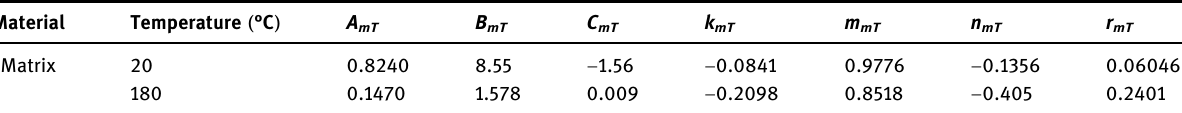
Table 6: Unknown parameters of the matrix damage evolution equation